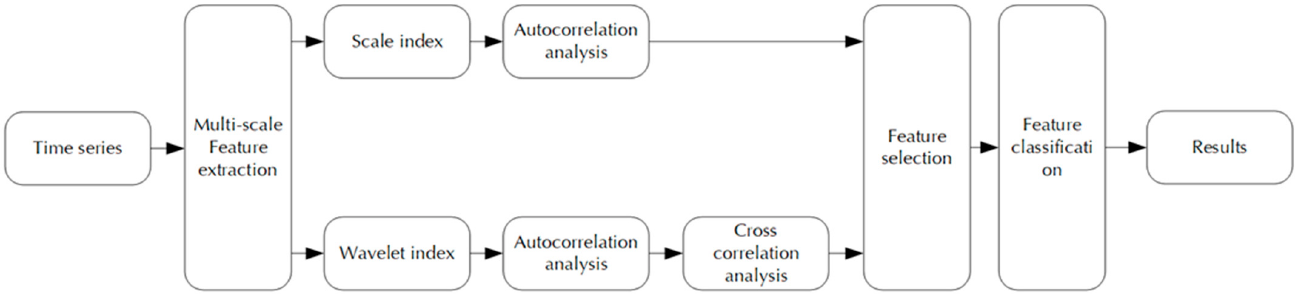
Figure 4. A model of multiresolution analysis used for stock price prediction.